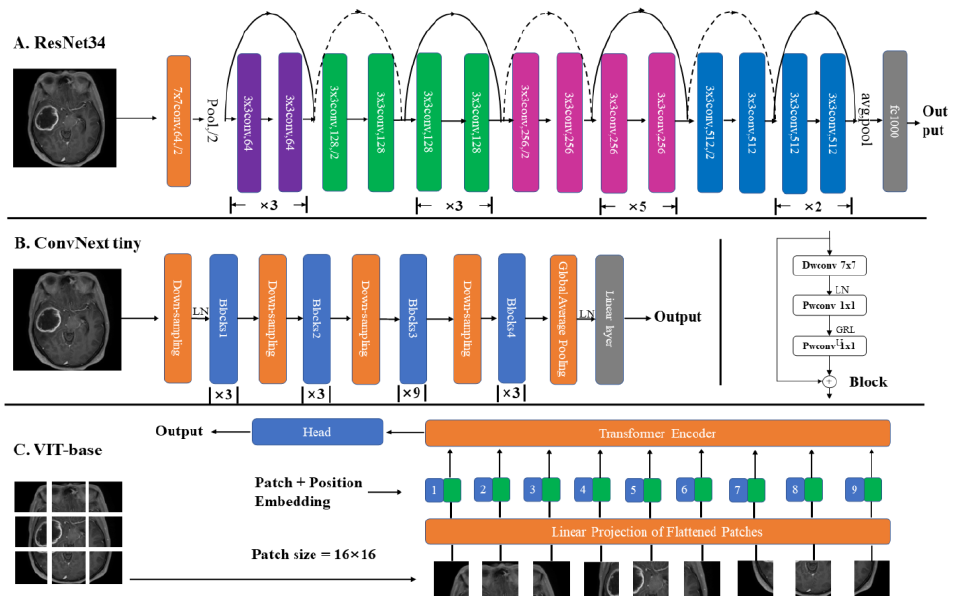
Figure 4. Structure of different networks. ( A ) the structure of ResNet34. The mark under the block indicates the number of repetitions of the block in this group. ( B ) the structure of ConvNext. The block structure could be seen on the right, which consists of two pointwise (PW) convolutions and a depthwise convolution (DW) convolution, seen on the right. ( C ) the structure of Vit. Contains Patch + Position Embedding and Transformer Encoder.